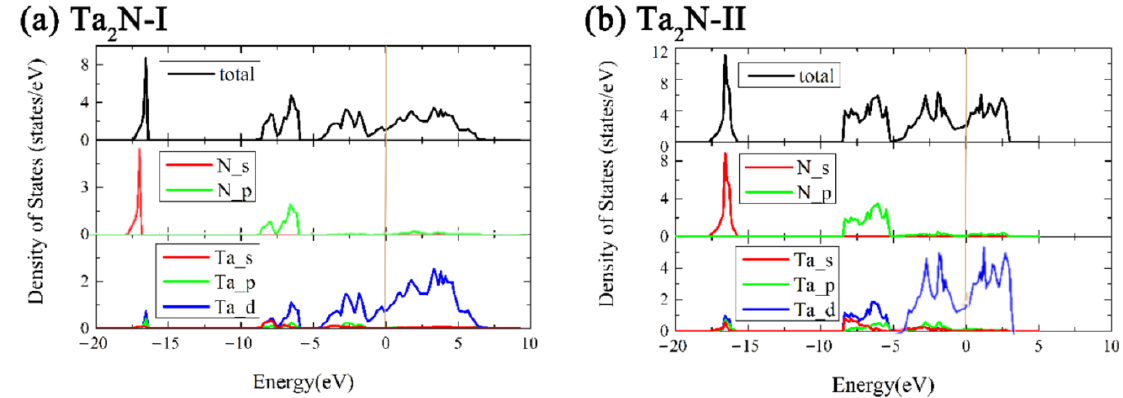
Figure 5. Total and partial density of states ( a ) Ta 2 N-I and ( b ) Ta 2 N-II. The vertical line denotes the Fermi energy level.